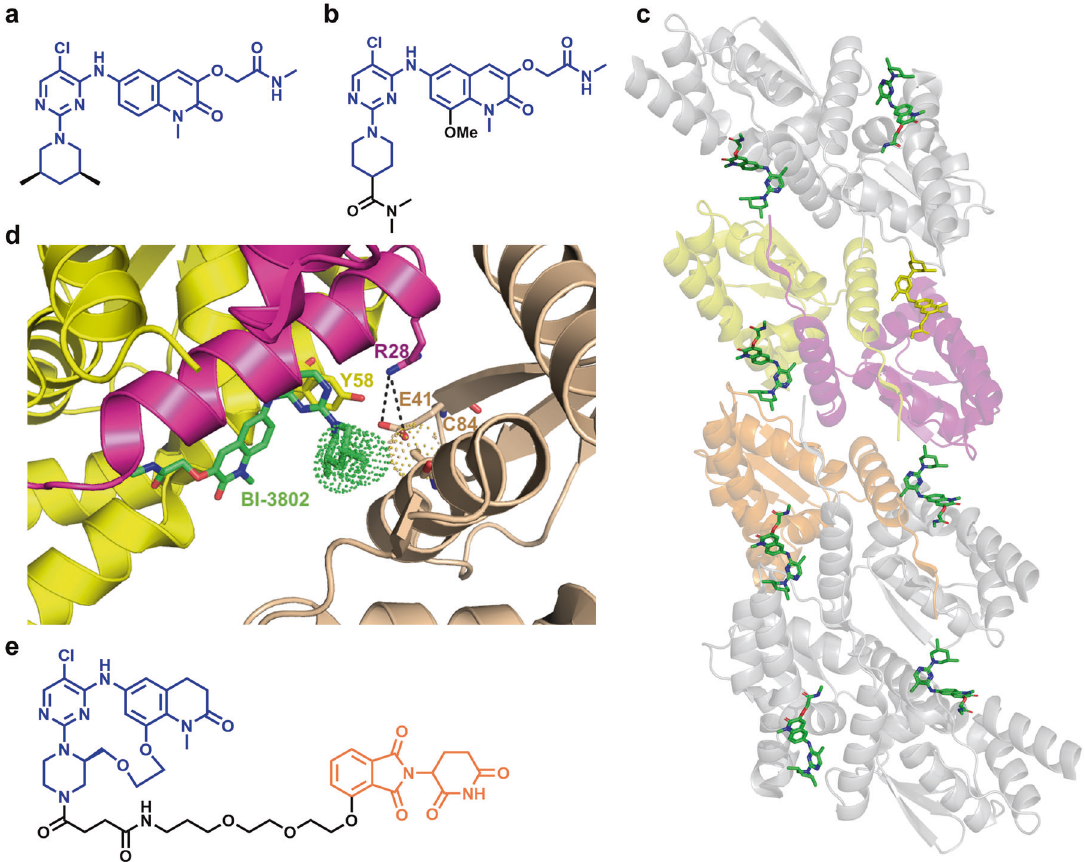
Fig. 1 Small molecule BCL6 modulators and the binding mode of the BCL6 molecular glue. a Structure of BCL6 molecular glue BI-3802. b Structure of BCL6 inhibitor BI-3812. c Cyro-EM model of BCL6 fi lament with BI-3802 PDB code (6XMX). d Binding mode and key interaction made by BI-3802 (green) at the interface of BTB α (yellow), BTB β (magenta), and BTB γ (orange) domains. e Structure of BCL6